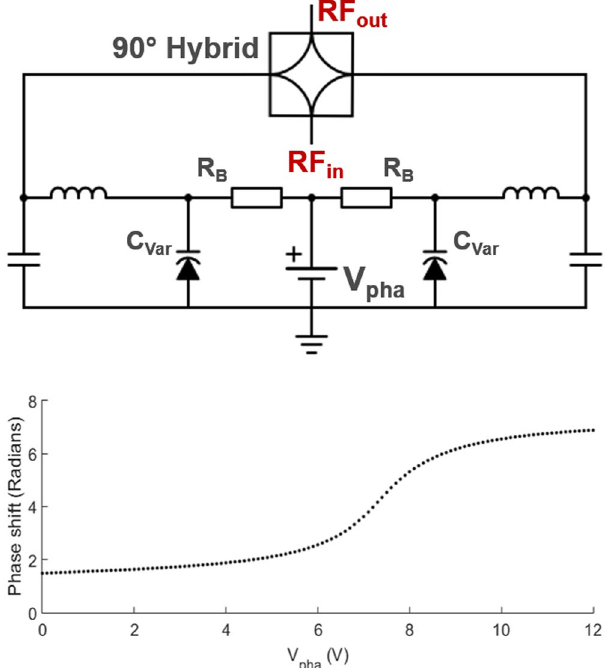
Figure 2. Voltage controlled phase shifter circuit schematic, and voltage versus phase plot. R B stands for bias resistors. The phase shifter enables 280° coverage for 0 V < V 1 < 12 V. Nonlinear behavior is taken into account by using variable voltage step sizes in automated feedback